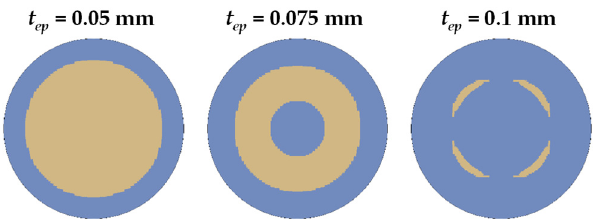
Figure 13. Predicted stripping pattern for different values of epoxy thickness. Aluminum’s thickness is 0.97 mm, spot diameter is 4 mm and P max = 2639 MPa.